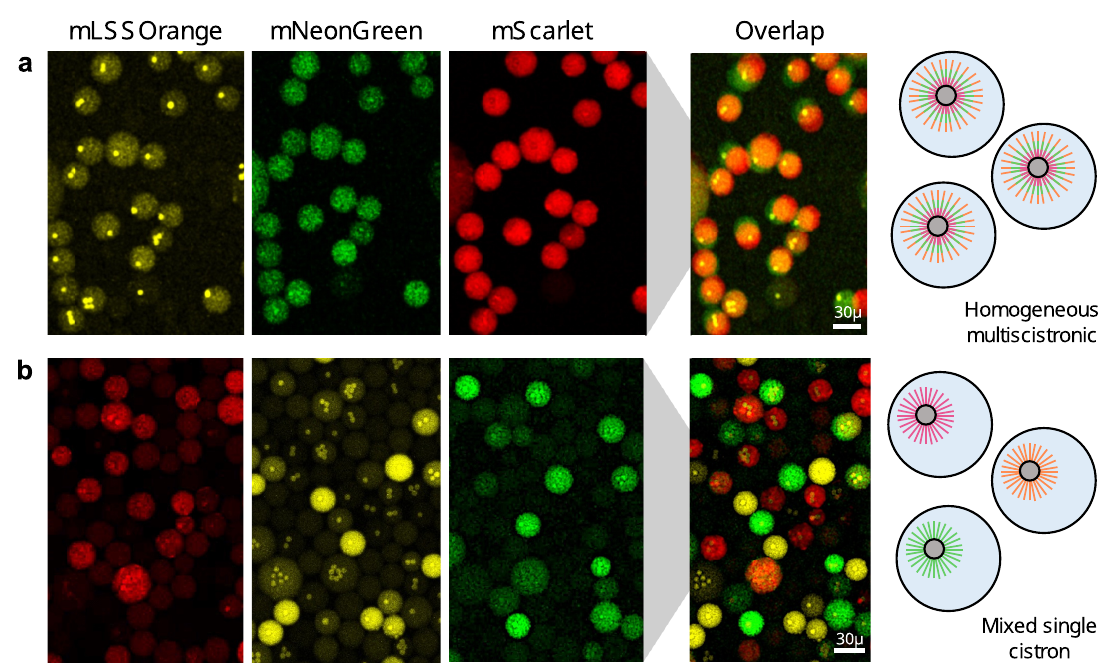
Fig 4. Co-expression or parallel expression of three different proteins from beads in droplets. (a) For co-expression in the same droplet, three genes encoding different fluorescent proteins were concatenated onto beads using Golden Gate assembly and beads were encapsulated with cell-free system. Co-expression of LSSmOrange, mNeonGreen, and mScarlet-I in all droplets is evident from imaging in the three different emission channels (note that droplets may be moving between images). (b) For parallel expression, genes were immobilized onto beads separately, beads were mixed and encapsulated together. Imaging in the three emission channels shows that most droplets only express one of the three fluorescent proteins.